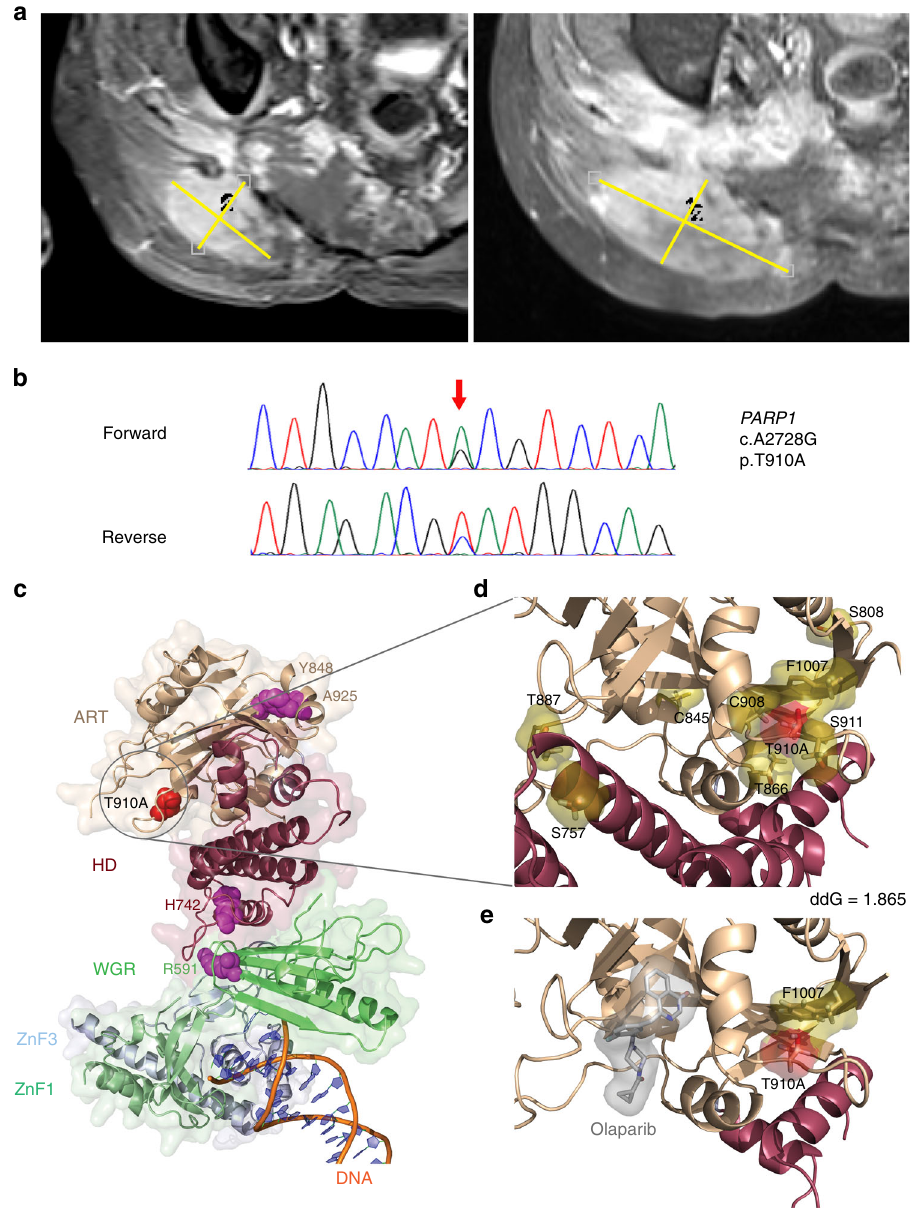
Fig. 2 Acquired resistance to olaparib treatment in chordoma. a T1-weighted, fat-saturated, post-contrast MRI after 7 months (stable disease; left panel) and 10 months (progressive disease; right panel) of olaparib therapy. A biopsy for WGS was taken at progression (right panel). b Missense mutation in PARP1 exon 20 detected by Sanger sequencing. Nucleotide (arrow) and amino acid substitutions are given next to the chromatograms. Sequence numbering is according to NCBI Reference Sequences NM_001618 and NP_001609. c Structure of p.T910A-mutant PARP1 bound to DNA (PDB ID: 4DQY). Side chains of amino acids whose mutation has been linked to PARP1 inhibitor resistance (T910, this study; R591, H742, Y848, and A925, ref. 19 ) are represented as spheres. WGR tryptophan-glycine-arginine-rich domain; ZnF1 zinc- fi nger domain 1; ZnF3 zinc- fi nger domain 3. d Detail view of